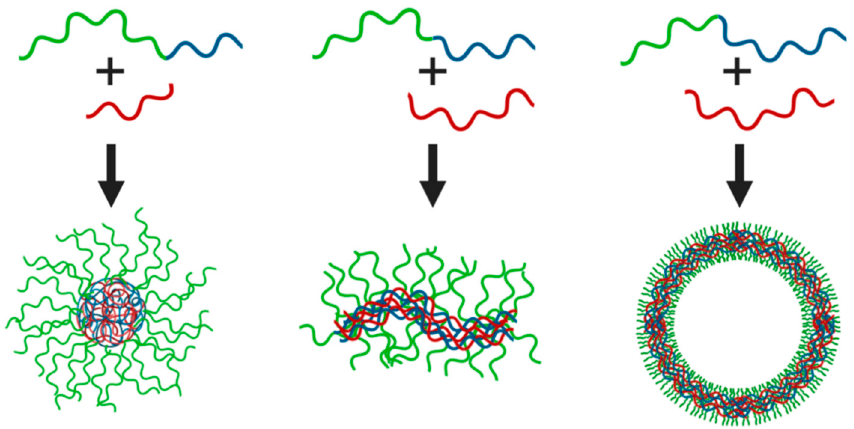
Figure 2. Schematic representation of the different assemblies formed by oppositely charged (block co)polymers. Relative block lengths can dictate the formation of spherical micelles ( left ), wormlike micelles ( middle ) or vesicles ( right ) with a complex coacervate core.